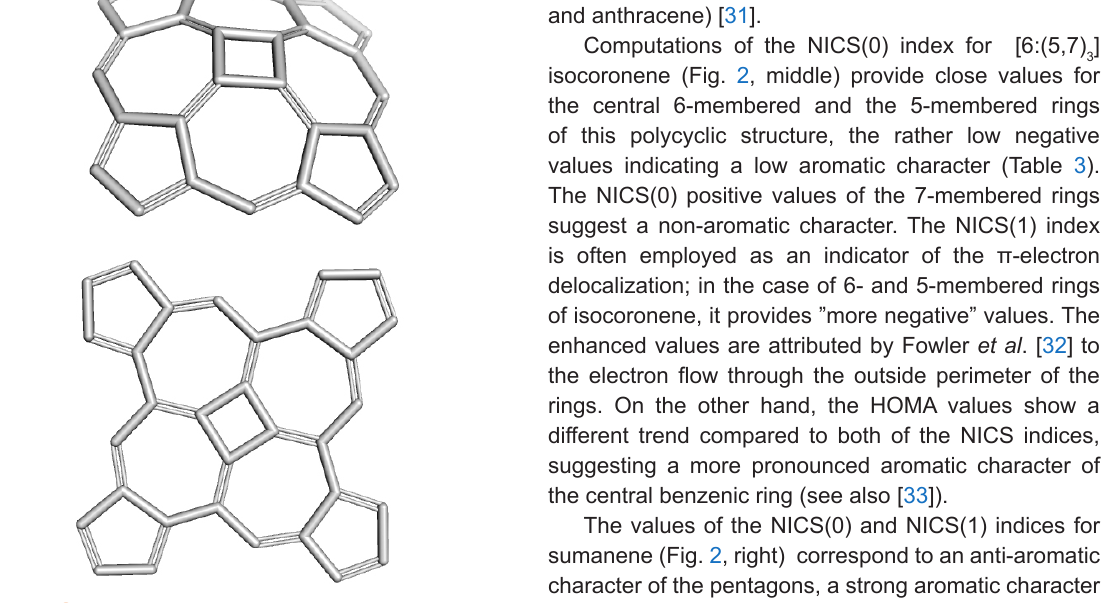
/C and the HOMO-LUMO gaps Δ computed at HF/6-31G(d) level of theory. tot tot